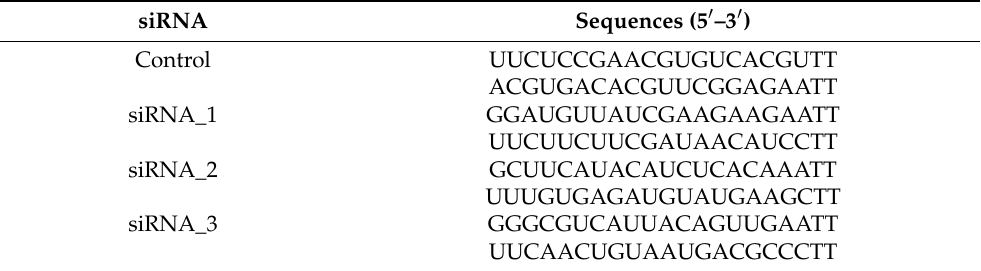
Table 2. SiRNAs used in this